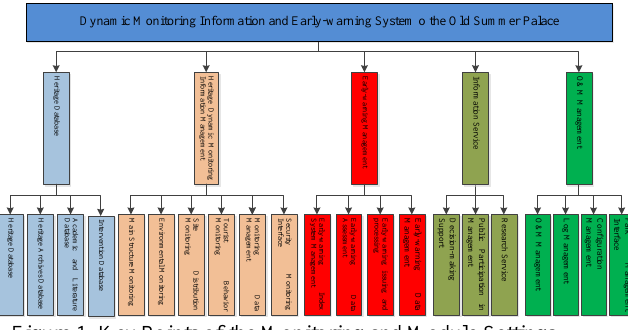
Figure 1. Key Points of the Monitoring and Module